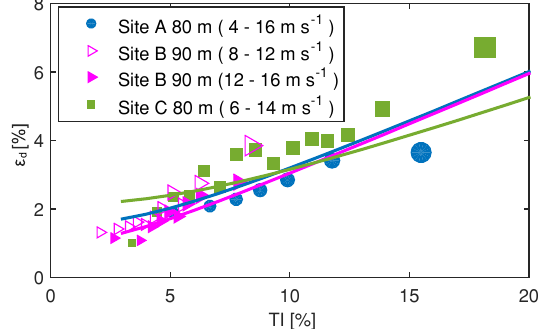
Figure 9. The relationship between the RSE of the relative differ- ence between lidar and cup measurements ( ε d ) and the turbulence intensity (TI) at the three sites. The 95% confidence interval for each observed RSE ( ˆ ε d ) is denoted by the marker size. The solid lines with matching colors are the predicted relationships at the sites. Prediction at Site A uses wind speed 8ms − 1 and wind direc- tion 150 ◦ , at Site B wind speed 10ms − 1 and wind direction 323 ◦ , and at Site C wind speed 10ms − 1 and wind direction 270 ◦ . Values of ε d here are derived from the cup errors related to the turbulence ( ε c ) and instrument ( ε cup ), and the predicted lidar RSE ( ε l ) accord- ing to Eq. (16) and Table